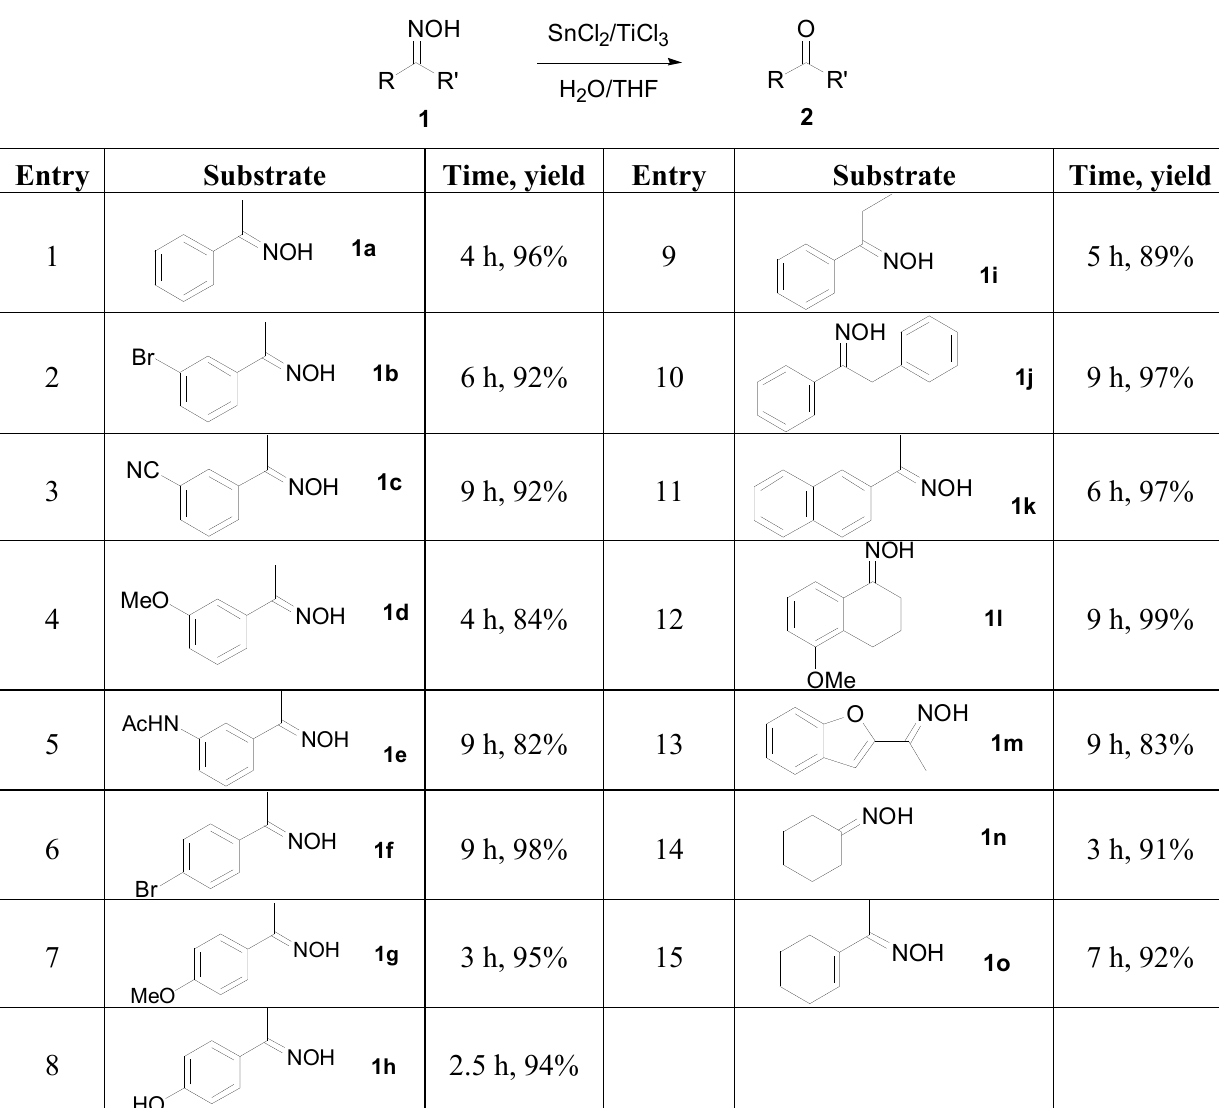
/TiCl -mediated deoximation of ketoximes a 2 3